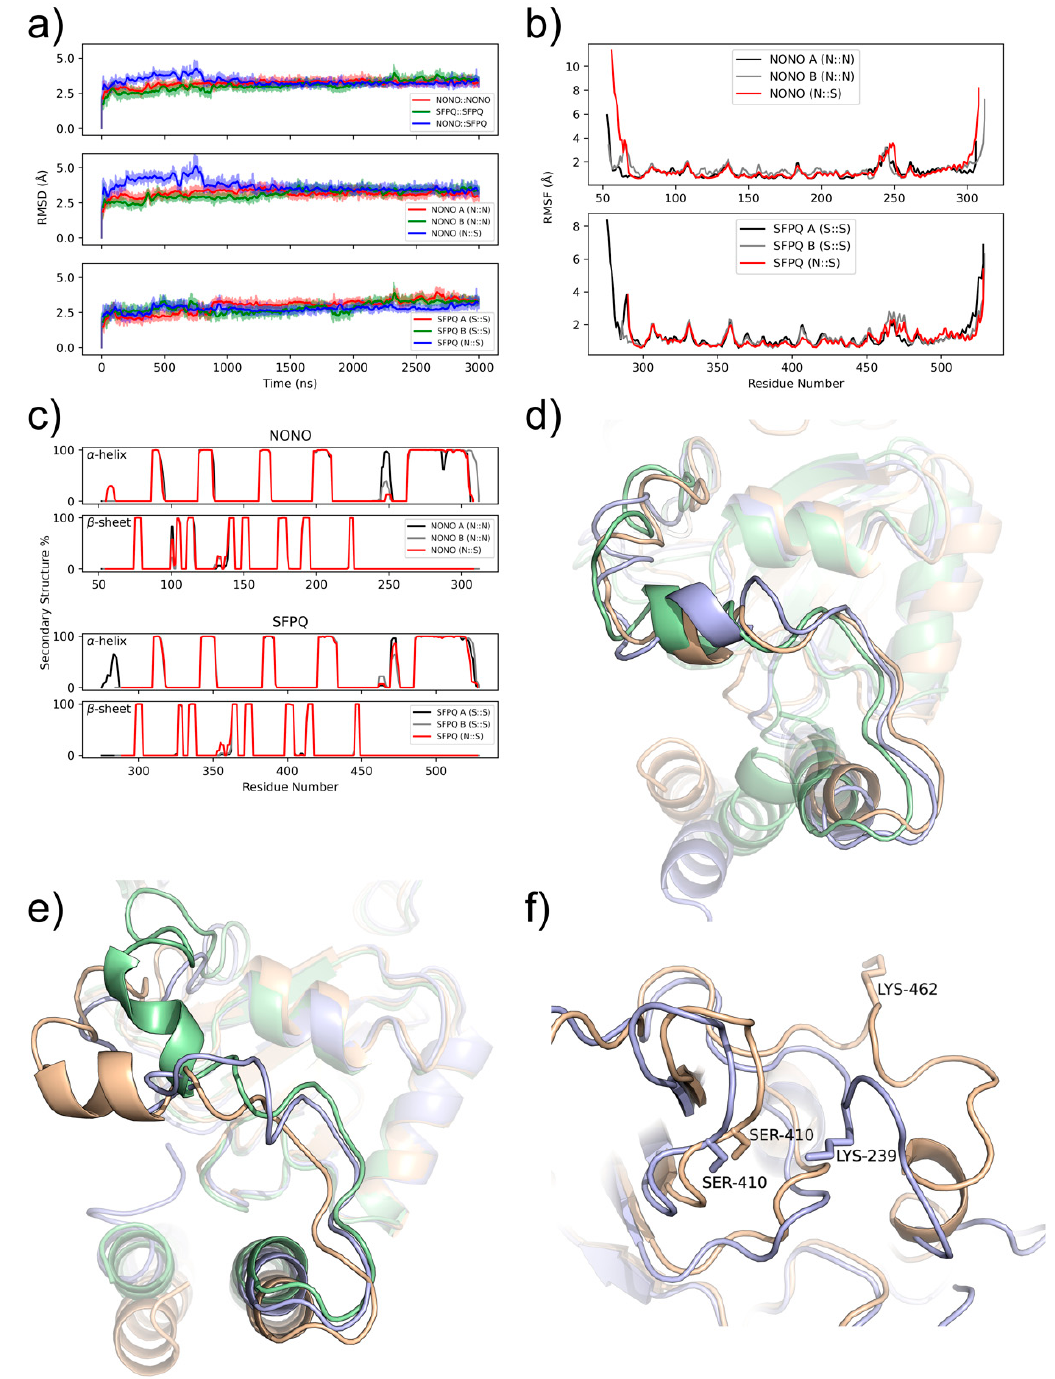
Figure 1. NONO and SFPQ dimers are highly stable. Through MD, we assessed NONO and SFPQ dimers stability. ( a ) RMSD converges to a stable plateau of 2.5 Å within 1 µ s for all systems. RMSD is reported for dimers (top) and individual chains of NONO (middle) and SFPQ (bottom). ( b ) RMSF is reported for individual chains in all dimer combinations; mobile regions overlap in all systems, with higher fluctuations at the N- and C-termini and NOPS region. ( c ) Secondary structure % over simulation time: α helix (top), β strands (bottom). ( d , e ) NOPS helix in NONO and SFPQ superposed structures: homodimer (yellow and green), heterodimer (blue). ( f ) SFPQ homo- (yellow) and heterodimer (blue) interaction between RRM2 β 2/ β 3 loop and NOPS.